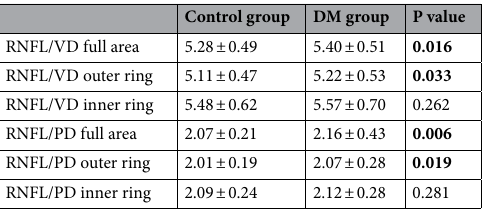
Table 3. The mean retinal nerve fiber layer thickness/vessel density ratio in each group. Significant values are in bold. RNFL retinal nerve fiber layer, VD vessel density, PD perfusion density.